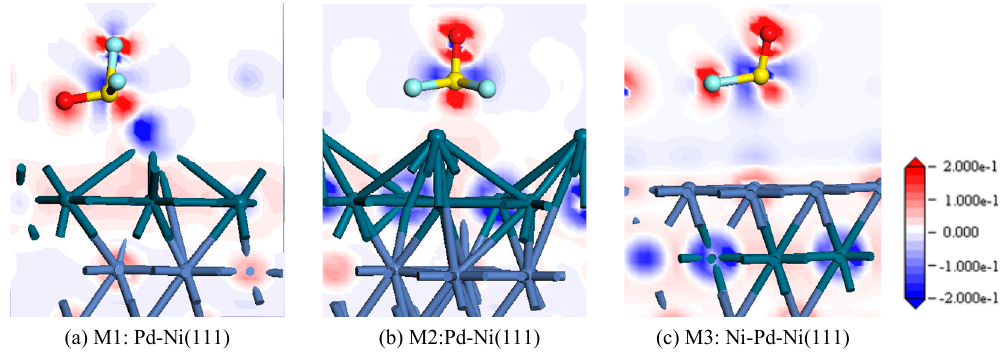
Figure 4. Electron density di ff erence of SOF 2 adsorption on the ( a ) M1:Pd-Ni(111), ( b ) M2:Pd-Ni(111), and ( c ) M3:Ni-Pd-Ni(111) surfaces.